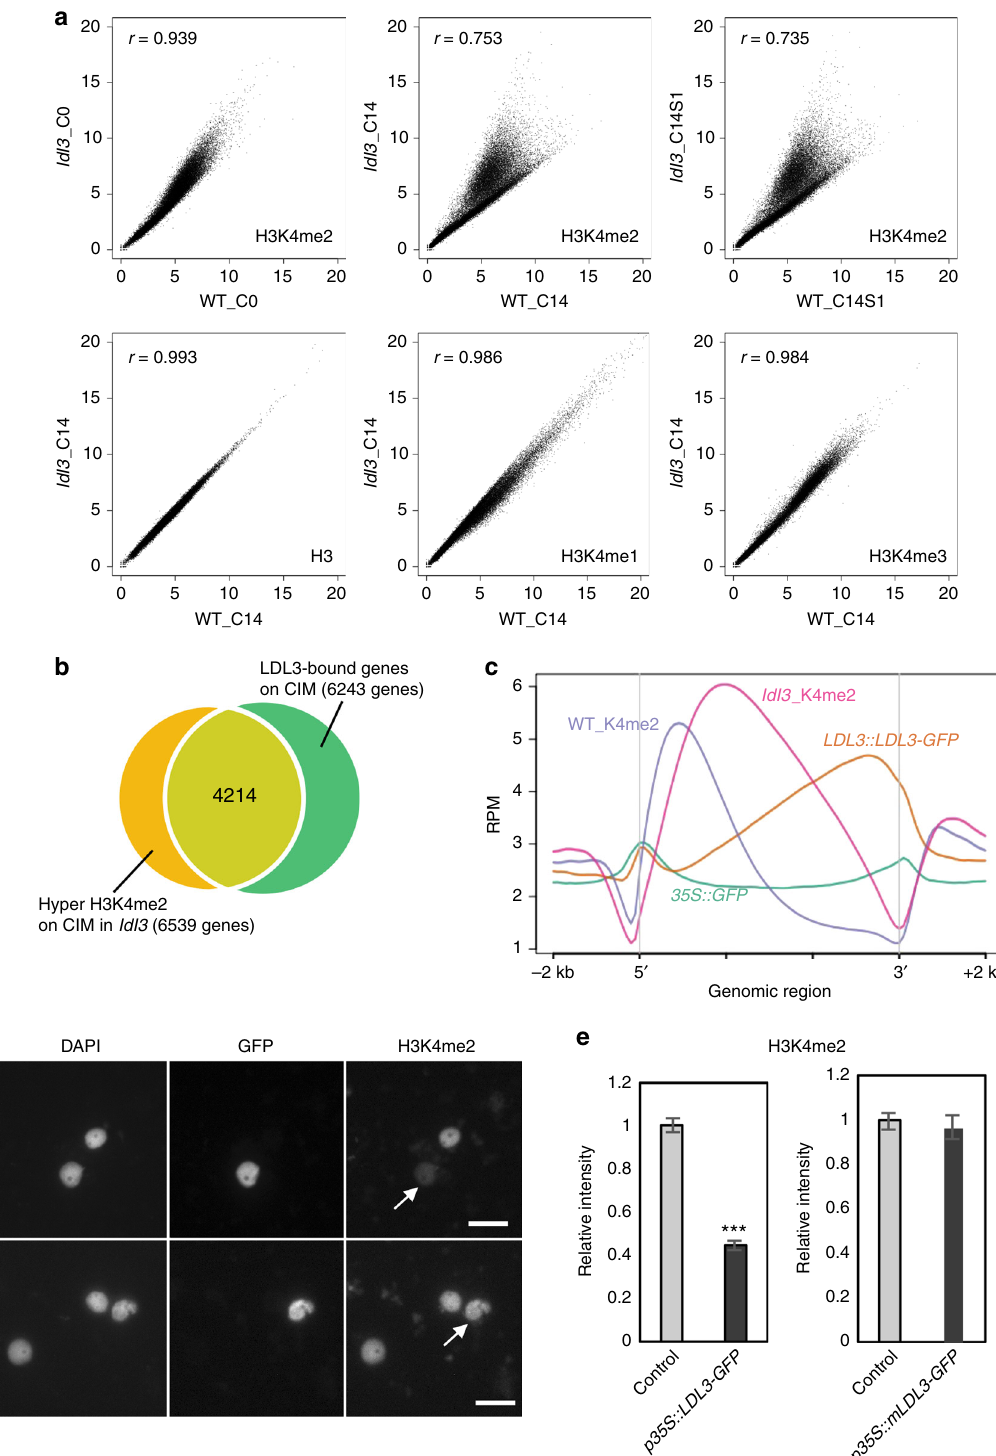
Fig. 4 LDL3 preferentially regulates the removal of H3K4me2 in CIM. a H3 and H3K4 methylation levels in ldl3 compared with WT at each stage. Each dot represents the square root of RPM. r : Pearson correlation coef fi cient. b Venn diagram of the genes with hyper H3K4me2 in ldl3 (read count_ ldl3 /WT > 1.5, p < 0.01) and LDL3-bound genes (identi fi ed by comparison of ChIP pro fi les for GFP in pLDL3::LDL3-GFP / ldl3 and p35S::GFP/ WT ( q < 0.1)) (C14). c Positional pro fi les of H3K4me2 and LDL3 on 6243 LDL3-bound genes. d Nuclei transfected with p35S::LDL3-GFP or a mutated construct p35S::mLDL3-GFP were mixed with control nuclei without transfection. All nuclei were visualized by DAPI staining, and GFP and H3K4me2 were visualized by immunostaining. Arrows indicate nuclei transfected with p35S::LDL3-GFP or p35S::mLDL3-GFP . Scale bars: 20 µ m. e Quanti fi cation of the immunostaining signals. The transfected nuclei with GFP signal versus non-transfected nuclei without GFP signal (control) were observed. A maximum of fi ve control nuclei per one transfected nucleus were randomly picked up from the same fi eld and assessed for signal intensity. Values are mean ± s.d. *** p < 0.001 (Student ’ s t -test). 132 < n < 242 (Control), n = 59 ( p35S::LDL3-GFP ), n = 34 ( p35S::mLDL3-GFP ). Source data are provided as a Source Data fi